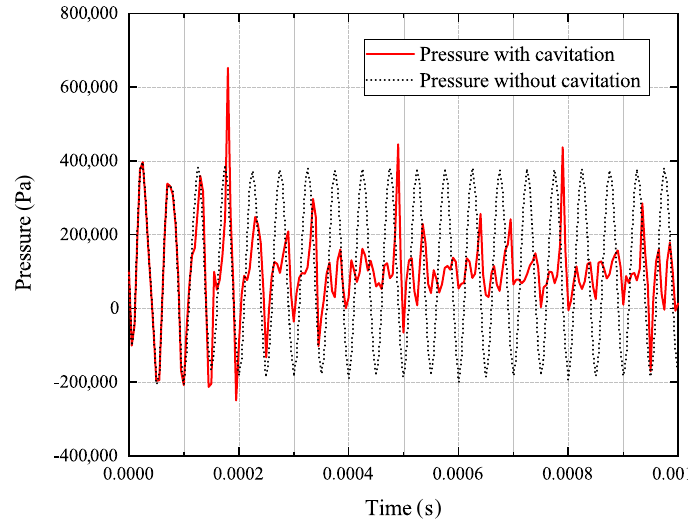
Figure 8. Comparison of acoustic pressure amplitudes 4 mm below the radiator with and without the activated cavitation model.